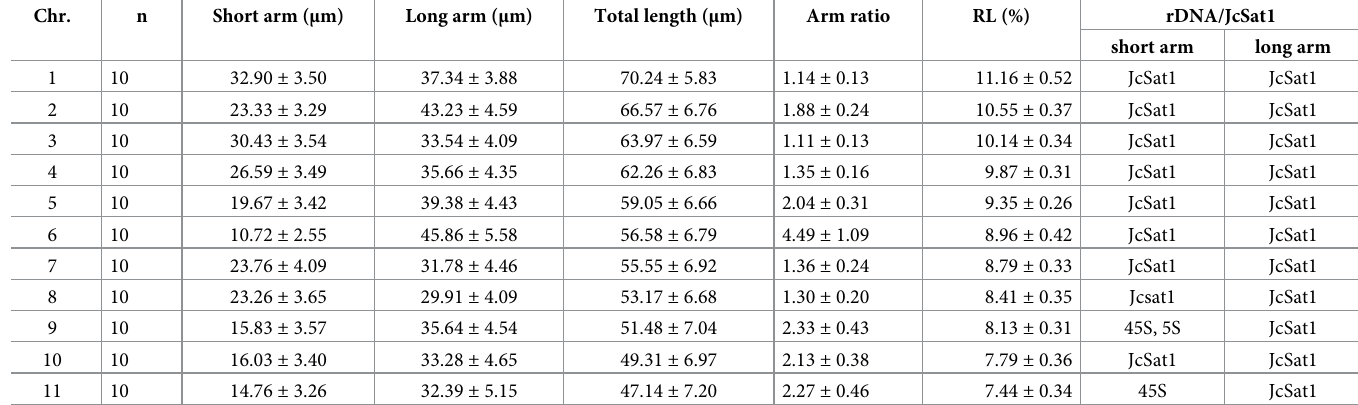
Table 1. Mean ± SD for morphometric and physical location of JcSat1, 45S rDNA and 5S rDNA on J. curcas pachytene chromosomes. Chr.